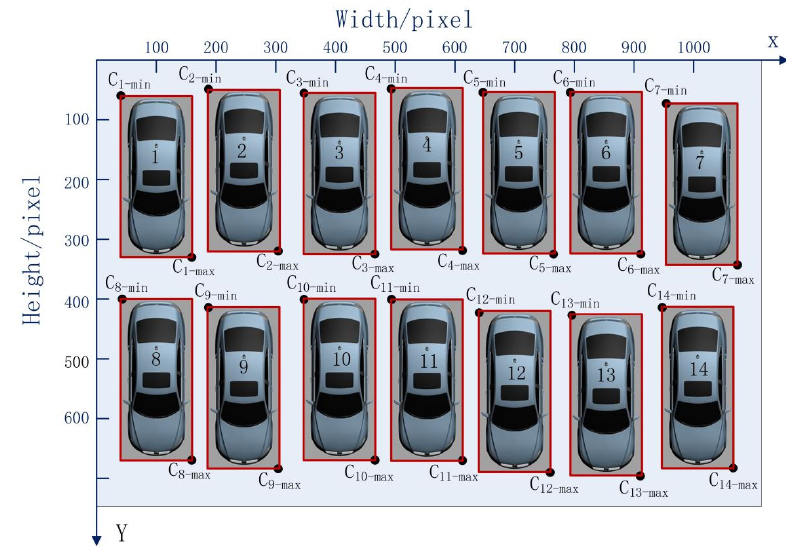
Figure 6. Each vehicle number after sorting with the data layering method.